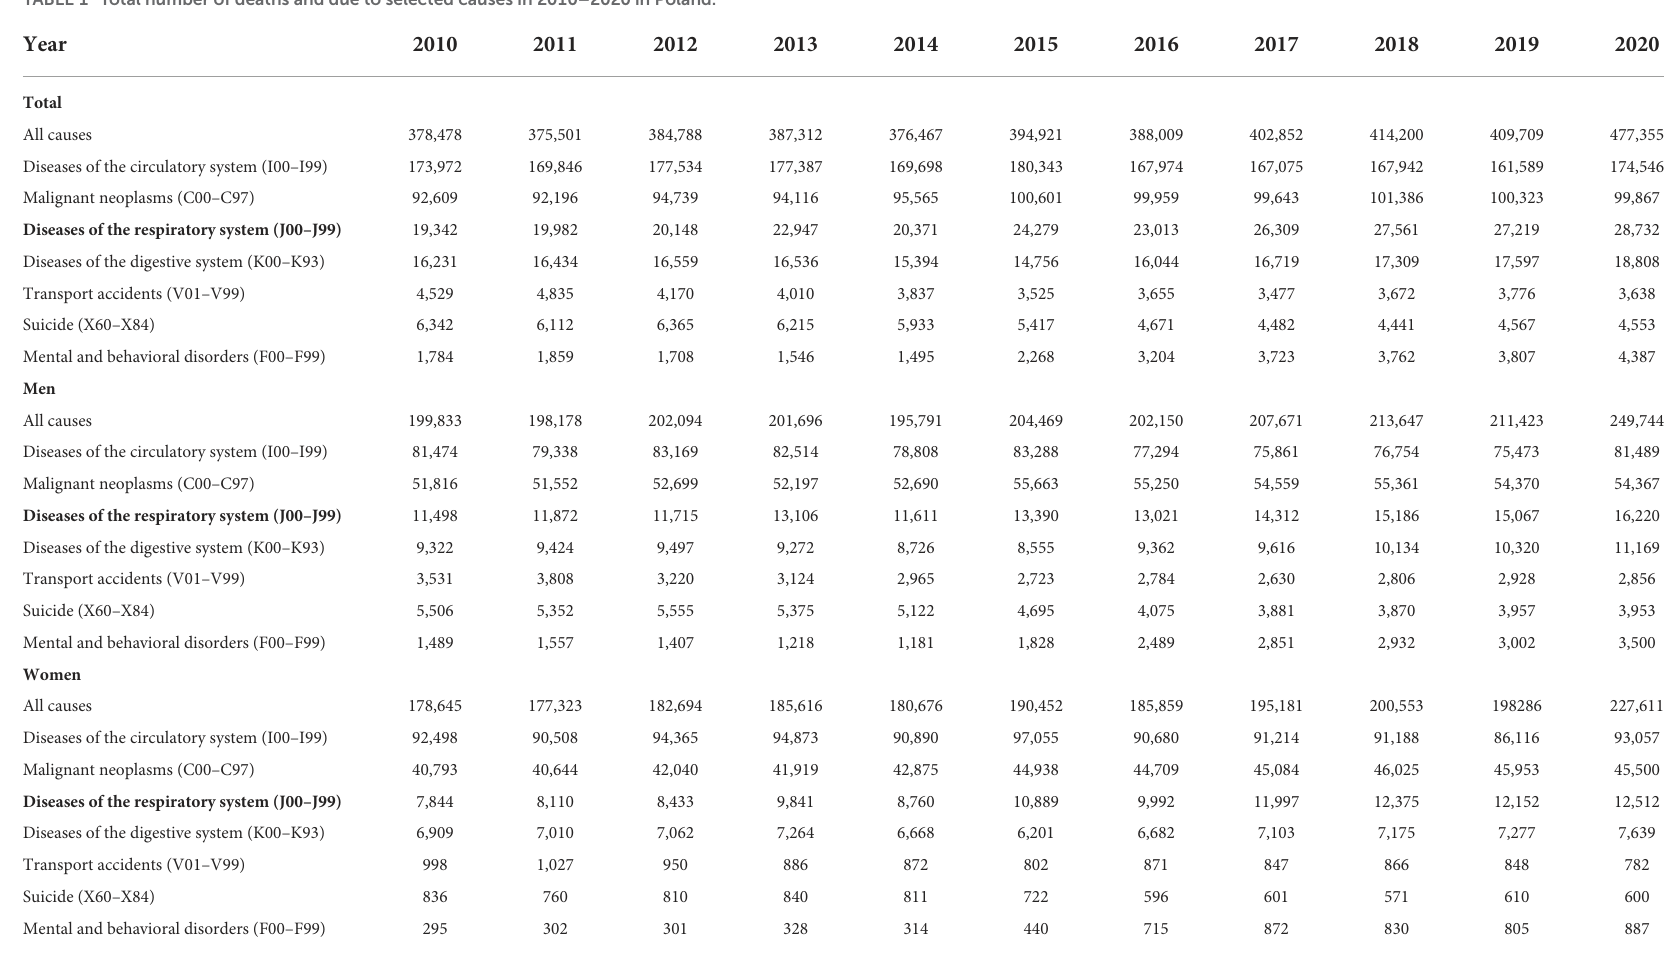
TABLE 1 Total number of deaths and due to selected causes in 2010–2020 in